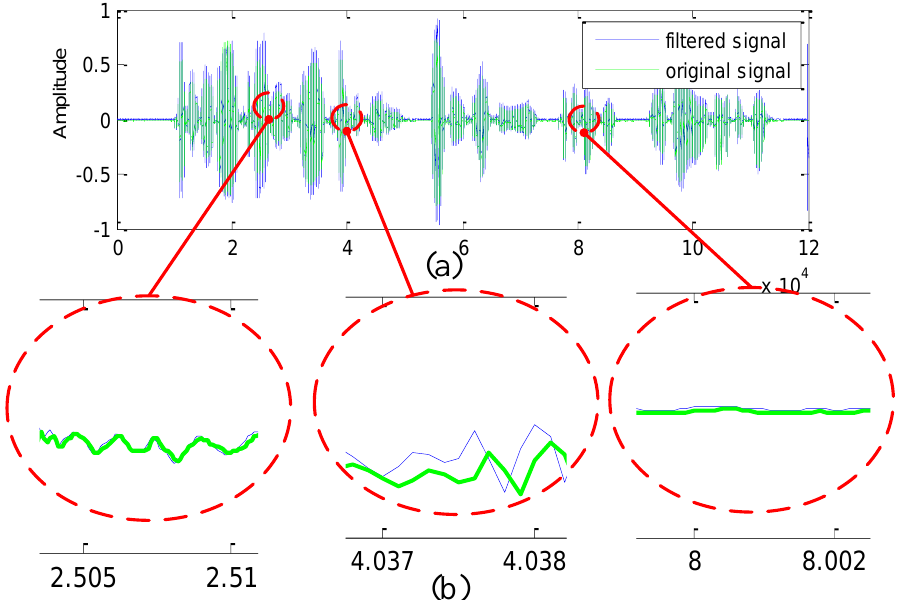
Figure 10. The signal waveforms filtered by the proposed notch filter: ( a ) The original waveform and the filtered waveform; ( b )The enlarged